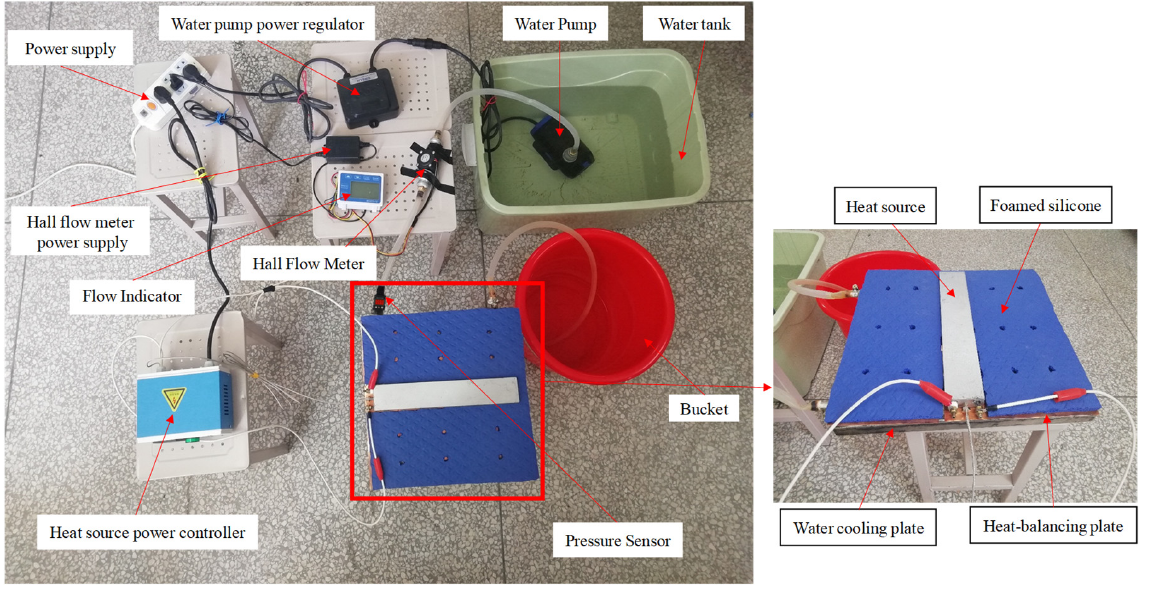
Figure 9. Picture of the experimental setup.